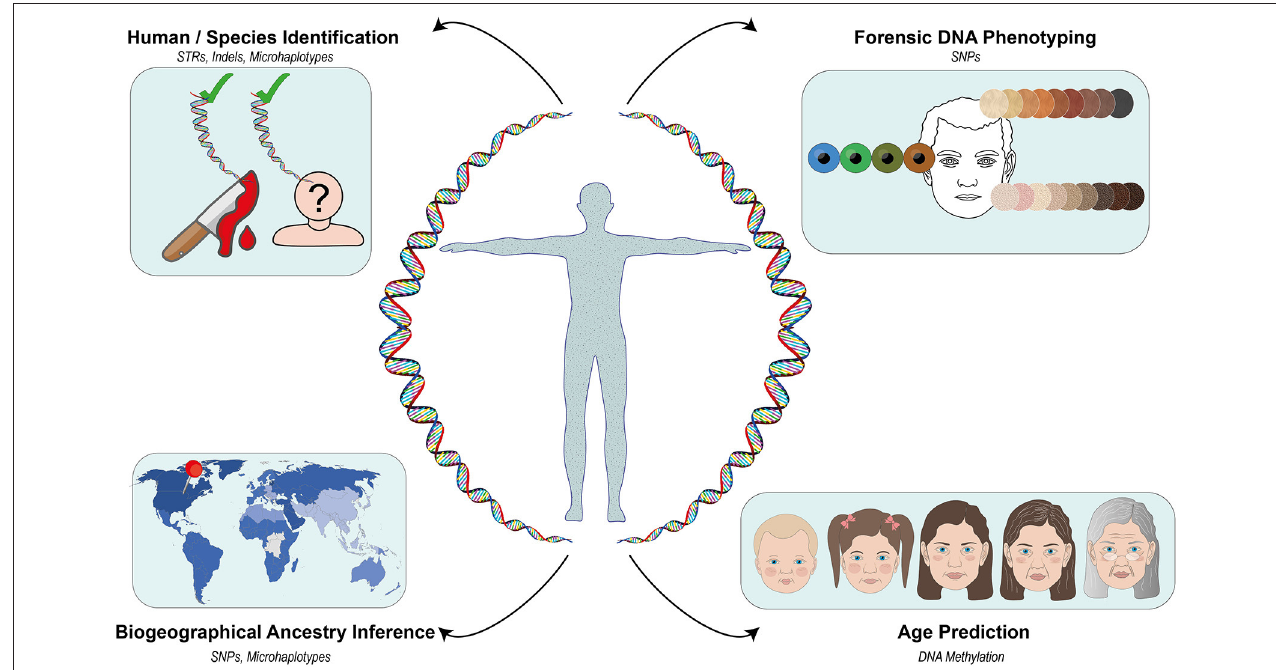
FIGURE 1 | An overview of the genetic markers covered in the Current and Emerging Trends in Human Identification and Molecular Anthropology Research